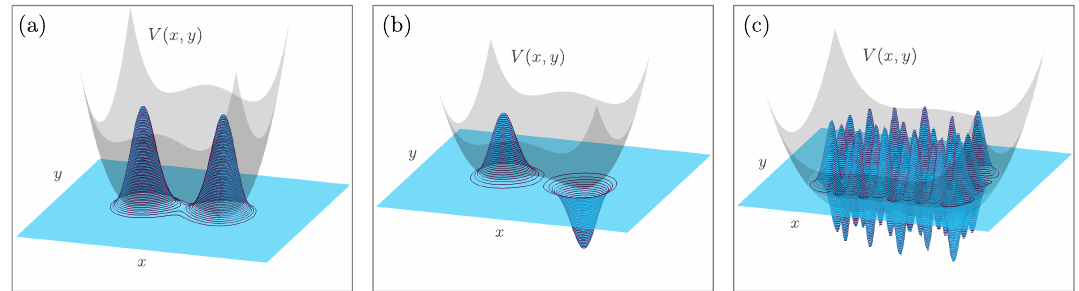
Figure 1: Illustration comparing classical eigenstates obtained from the Gibbs distribution (blue surface plots) and quantum eigenstates obtained solving the stationary Schrödinger equation (black wire mesh) for a two-dimensional